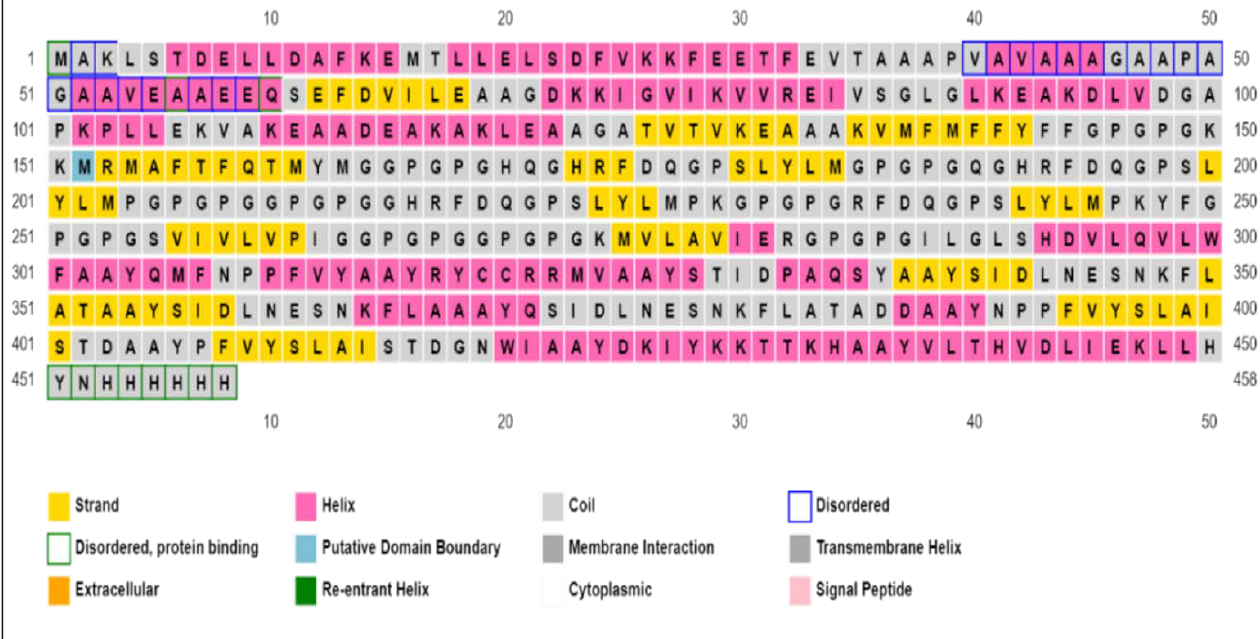
Figure 5. Secondary structure prediction of the constructed vaccine.